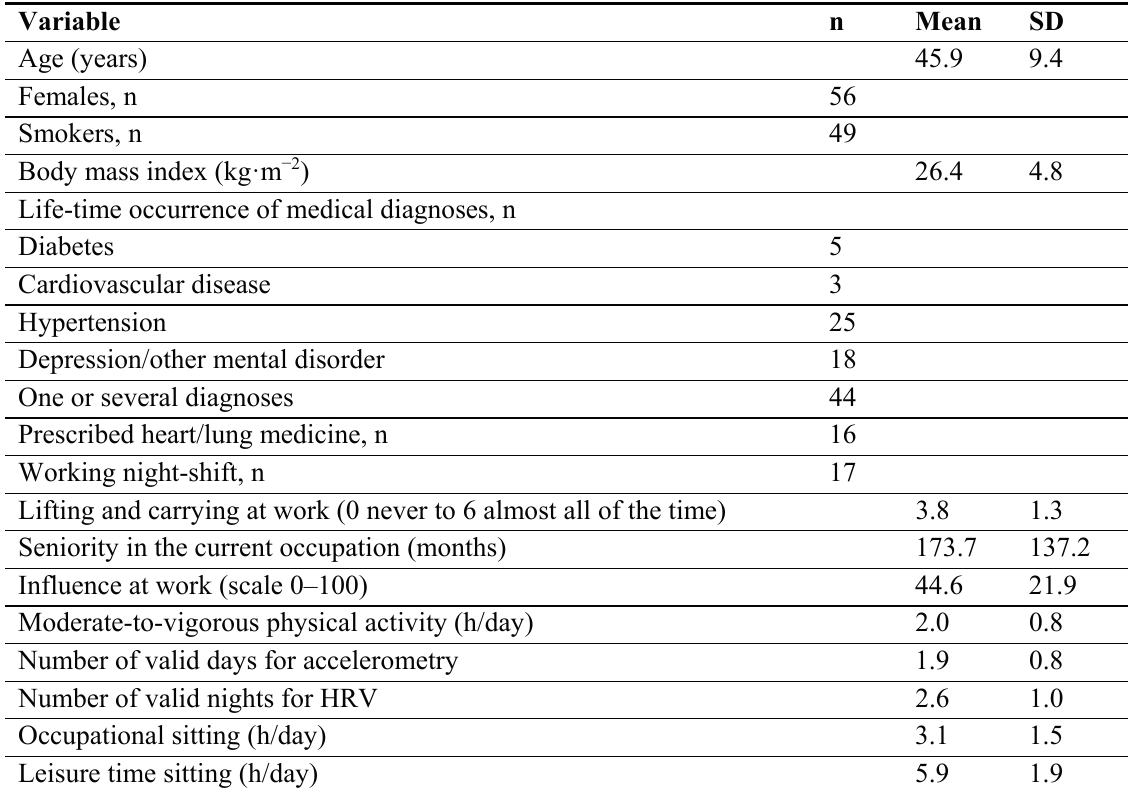
Table 1. Descriptive information of the blue-collar workers (n = 126) with valid measures of accelerometry and heart rate variability.